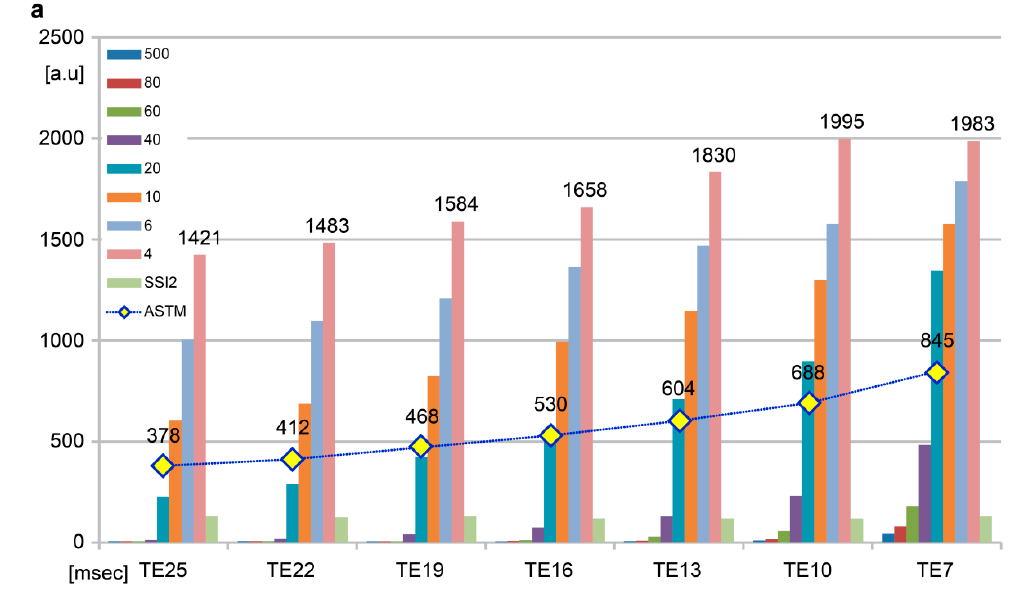
11 of 13 Figure 7. Graphs of SI changes in the clinical study. ( a ) changes in SI at different concentrations and ASTM by TE; ( b ) changes in SSI 1 , SSI 2 , FSI 2 , SBP, SC, and MPSI, by TE; ( c ) changes in EPSS, AEPSS, EPSC, and AEPSC by TE. SI, signal intensity; ASTM, average of SI per TE for each molar concentration; TE, echo time; SSI 1 , saline signal intensity of the phantom study, SSI 2 , saline signal intensity in the clinical phantom; FSI 2 , fat signal intensity of the second phantom, SBP, SI of brain parenchyma; SC, SI of the intraventricular cerebrospinal fluid; MPSI, max peak signal intensity; EPSS, the enhancement percentage of SI for each mol by SBP; AEPSS, average EPSS; EPSC, enhancement percentage of SI for each mol by SC; AEPSC, average EPSC. Usually, when GBCA is delivered into the body, it mixes with the blood, resulting in a decrease in GBCA concentration over time. Based on this principle, each container in the clinical phantom can be considered to represent a mass or cancer. We obtained the contrasts between each phantom container and the brain images in Figure 6 as percentages, and compared the effect of TE on contrast enhancement in each container with that of the brain parenchyma, in order to quantify this contrast. For this purpose, we calculated EPSS and EPSC, as well as their corresponding averages, AEPSS and AEPSC, and have displayed these measures in both Table 4 and Figure 7c. Figure 7c shows a gradual increase in AEPSS and AEPSC with decreasing TE. Thus, if the phantom is considered to represent a tumor, given the decreasing GBCA concentrations after delivery into the body, minimizing the TE provided an overall increase in tumor contrast enhancement compared to healthy tissue. Based on the results of both the phantom and clinical studies, we found that both a faster and higher signal enhancement in CE-T1 by using a shorter TE. Moreover, a short TE in T1 imaging is useful for increasing contrast with brain parenchyma structures in the T1 effect examinations. In summary, in CE-T1 imaging, using a short TE facilitates differentiation of basic structures, provides faster contrast enhancement, and increases the extent of contrast enhancement. However, our study had a limitation that needs to be acknowledged. Although there are two methods for T1 effect: spin echo (SE) and turbo spin echo (TSE), the present study examined only the effects of changes in the TE parameter on T1 imaging using conventional SE, which has been usually used for T1 effect in the clinical field [2,7,8]. Therefore, further research with TSE should be performed in order to set a lower TE than that achieved with SE. Despite this limitation, our study findings are clinically relevant as we re-evaluated whether the TE parameter is being set appropriately in current, routine CE-T1 imaging and further demonstrated that TE adjustment can provide better contrast enhancement for diagnostic purposes. Figure 7. Graphs of SI changes in the clinical study. ( a ) changes in SI at different concentrations and ASTM by TE; ( b ) changes in SSI 1 , SSI 2 , FSI 2 , SBP, SC, and MPSI, by TE; ( c ) changes in EPSS, AEPSS, EPSC, and AEPSC by TE. SI, signal intensity; ASTM, average of SI per TE for each molar concentration; TE, echo time; SSI 1 , saline signal intensity of the phantom study, SSI 2 , saline signal intensity in the clinical phantom; FSI 2 , fat signal intensity of the second phantom, SBP, SI of brain parenchyma; SC, SI of the intraventricular cerebrospinal fluid; MPSI, max peak signal intensity; EPSS, the enhancement percentage of SI for each mol by SBP; AEPSS, average EPSS; EPSC, enhancement percentage of SI for each mol by SC; AEPSC, average